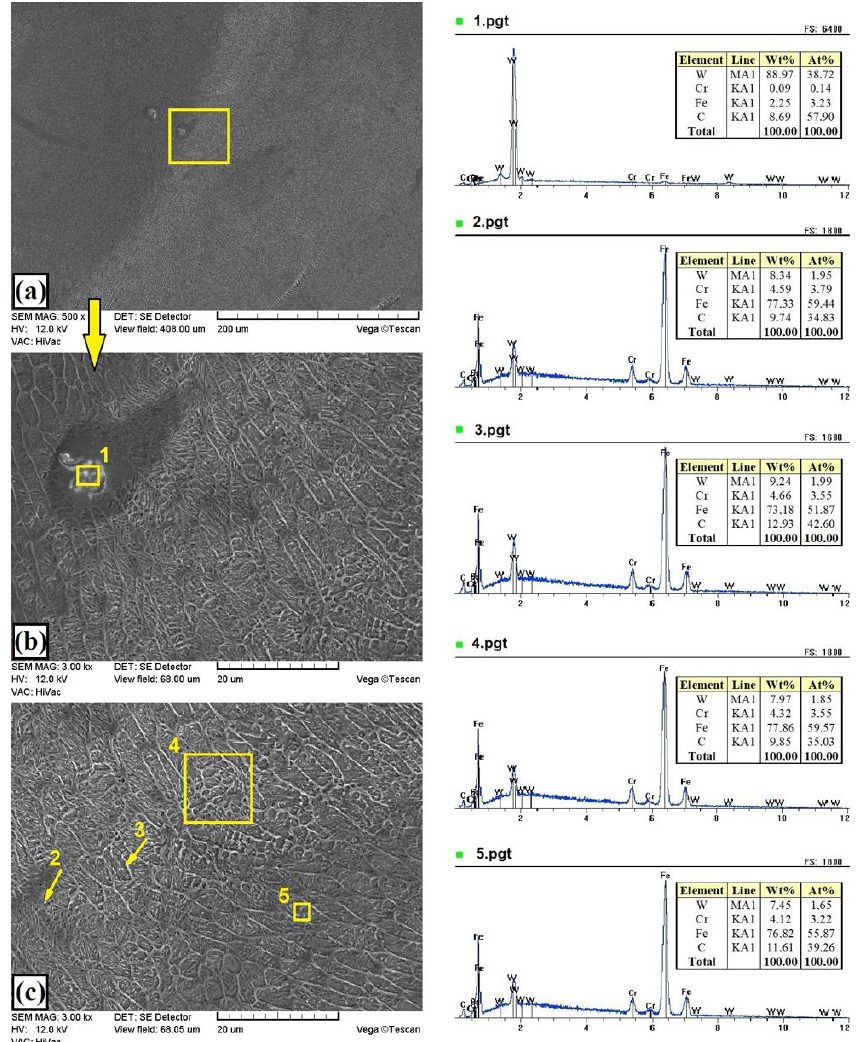
Figure 6. Microstructure and EDS point analysis of W–Cr coating reinforced with 25% WC particles produced using laser processing of the precoat applied on steel substrate: ( a ) general view of overlapping zone; ( b ) magnification of overlapping zone with unmelted WC particles; ( c ) matrix.